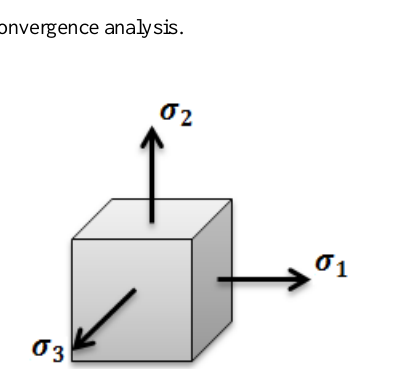
Figure 7. The principal stresses.